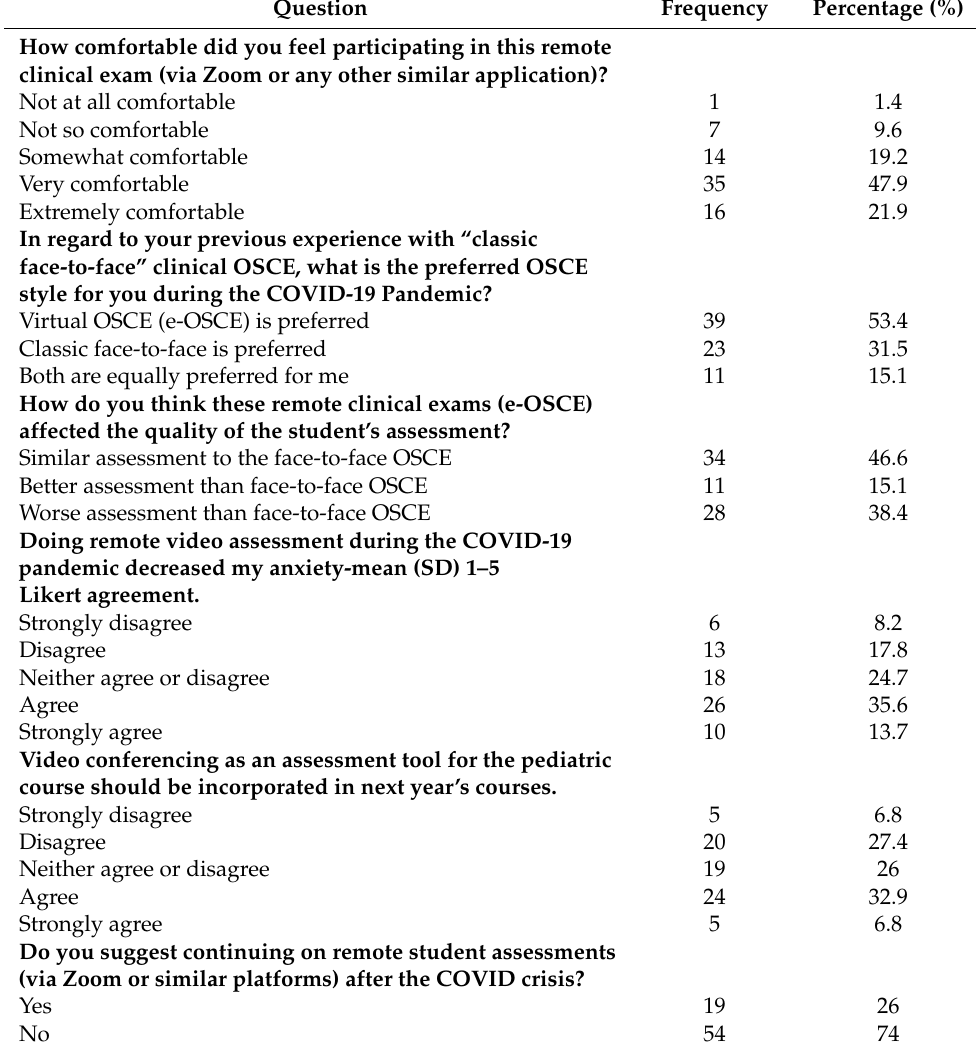
Table 2. Characteristics of the e-OSCE experience by the faculty and students ( n =